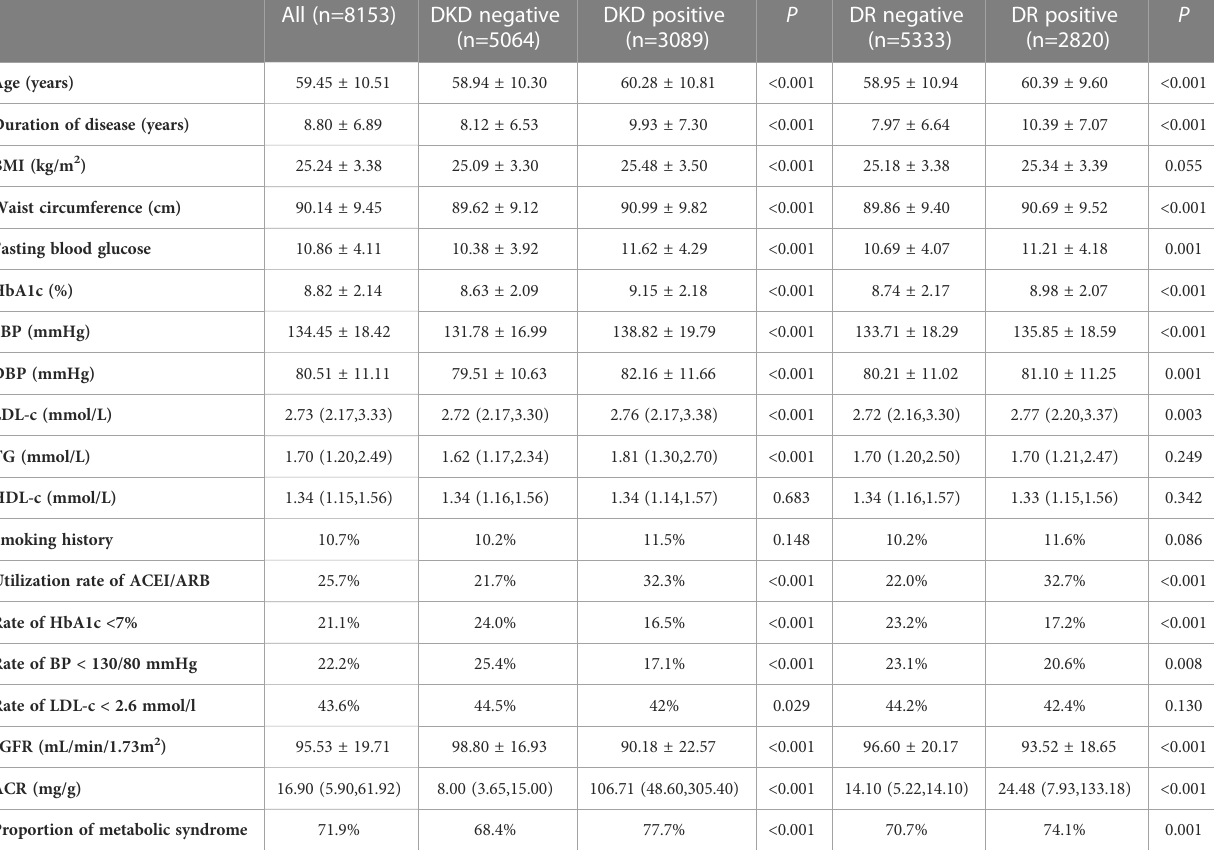
TABLE 1 Characteristics of different groups of patients with DKD negative, DKD positive, DR negative and DR positive. All